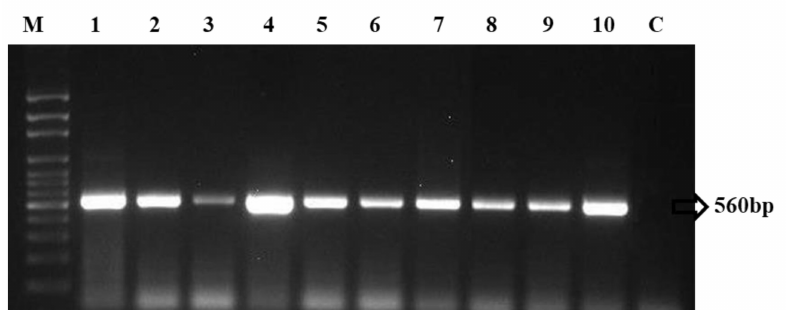
Figure 4. PCR amplification of Erysiphe specific ITS primer for the isolates of E. pisi.